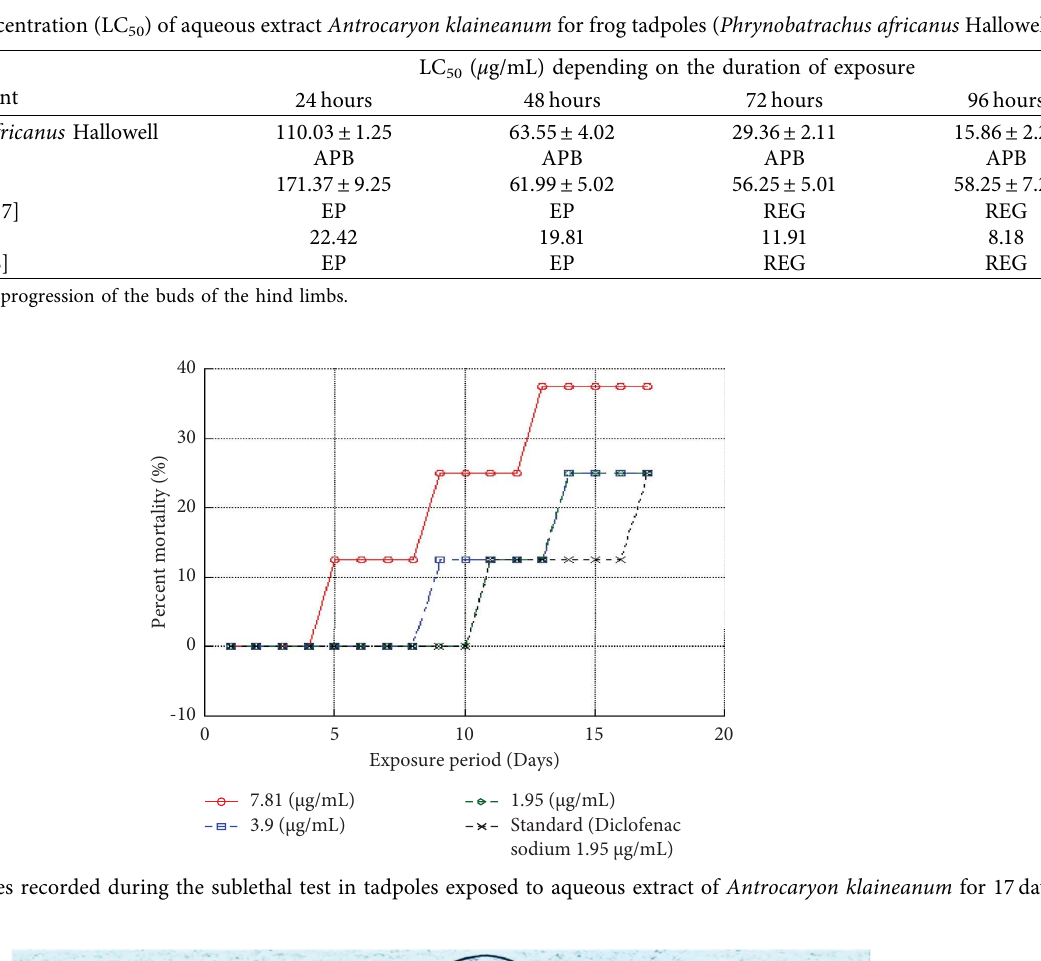
Table 1: Lethal concentration (LC